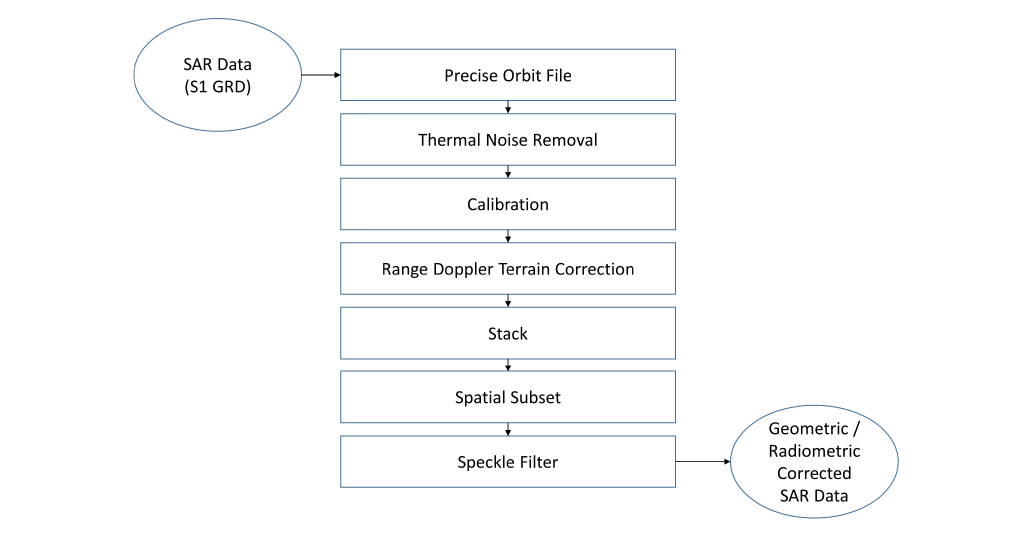
Figure 4. The Sentinel Application Platform (SNAP) preprocessing steps. SAR = synthetic aperture